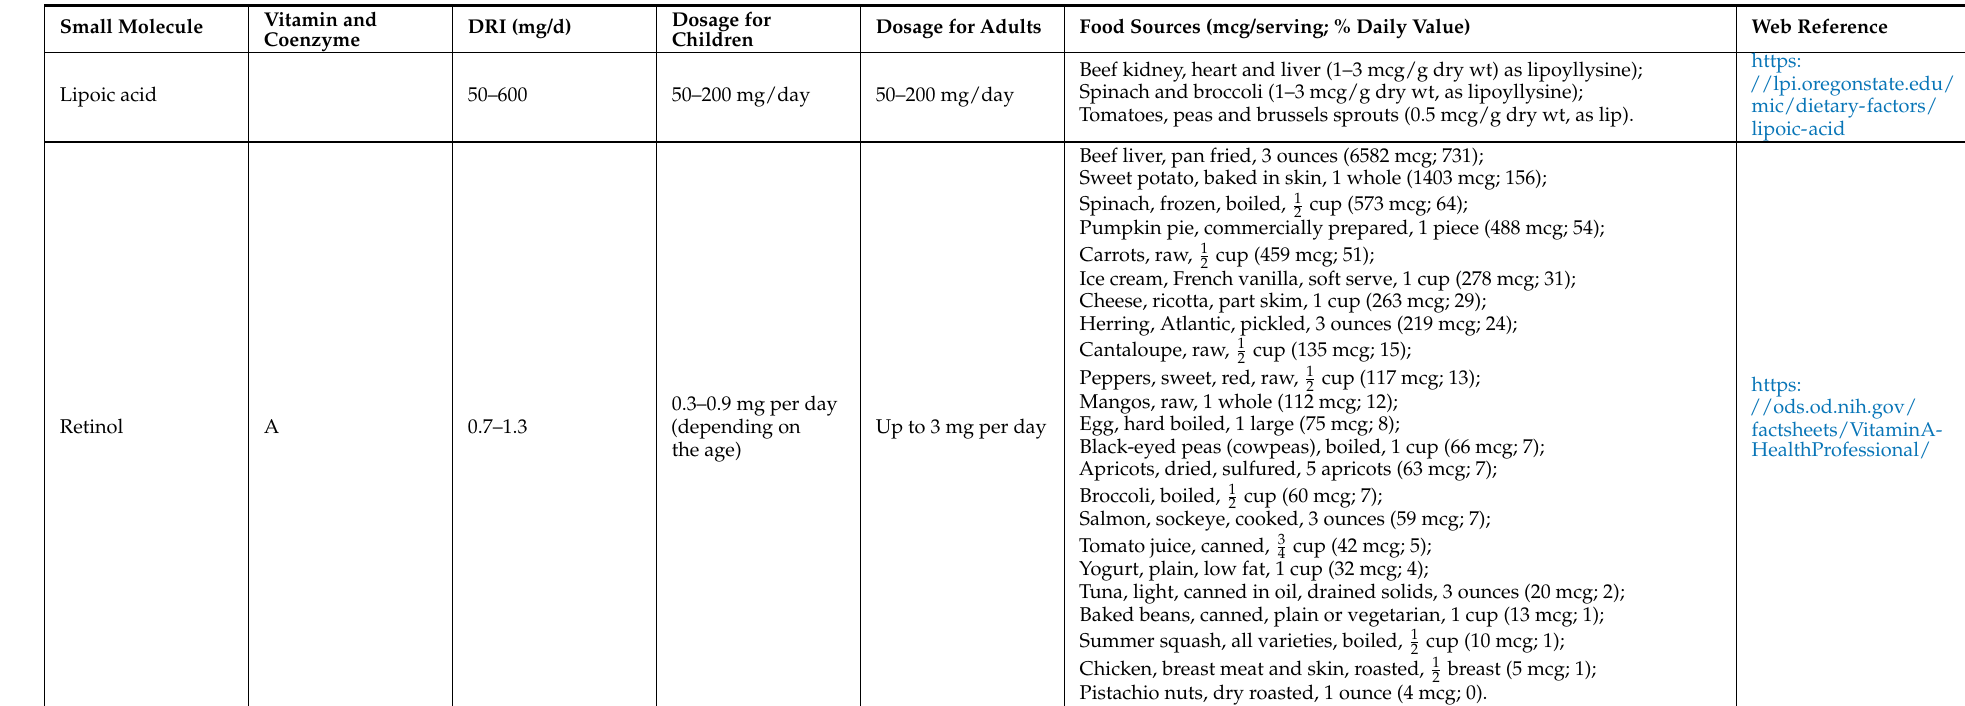
Table 2. Liposoluble (hydrophobic) vitamins: DRIs are reported according to https://www.ncbi.nlm.nih.gov/books/NBK222881/ and https://sinu.it/. An estimation of daily nutrient recommendations based on the DRI can be obtained by completing the linked form: https://www.nal.usda.gov/legacy/fnic/dri- calculator/index.php; https://ods.od.nih.gov/factsheets/VitaminE-HealthProfessional/. Dietary supplement dosages for children and adults are coherent with those reported in the cited references within paragraphs dedicated to each vitamin (see below) and/or with those reported in